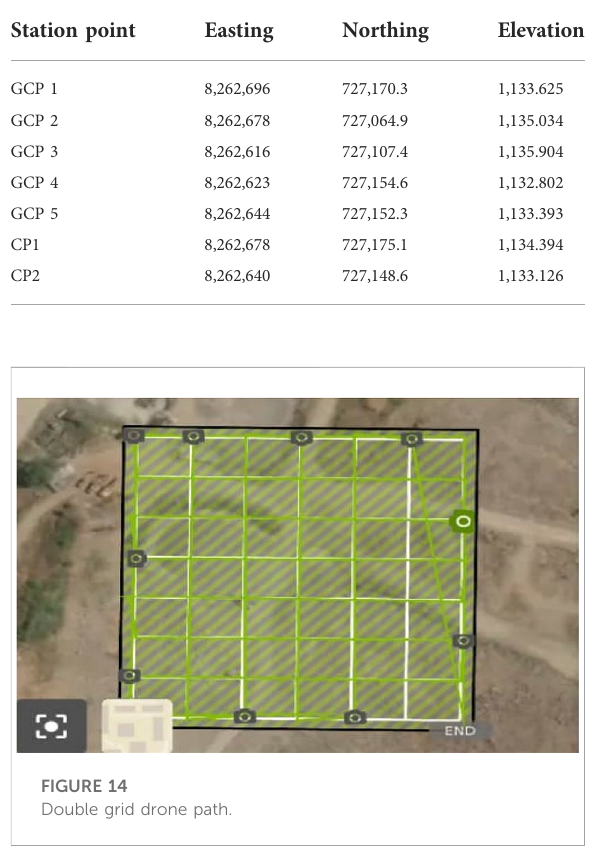
TABLE 4 The volume calculated in Pix4D